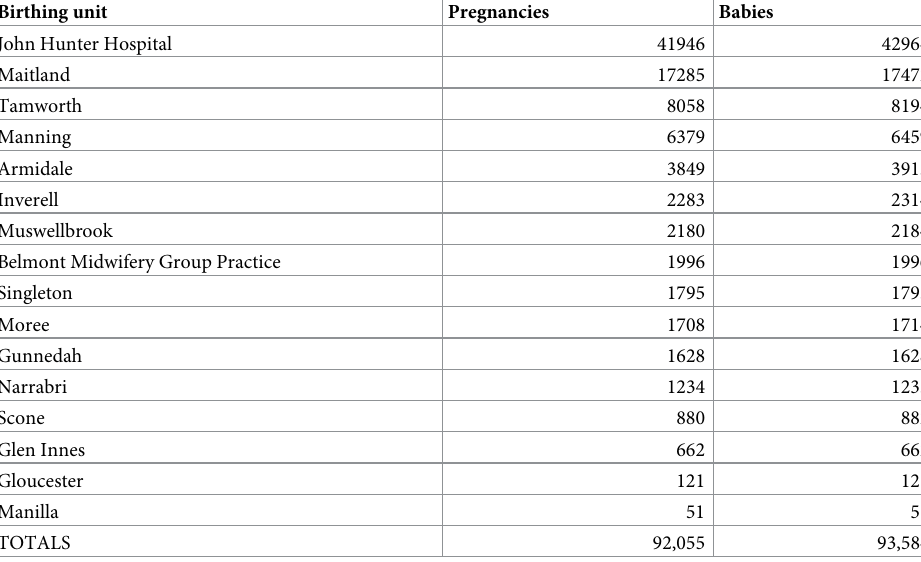
Table 1. Pregnancies resulting in live born babies per unit